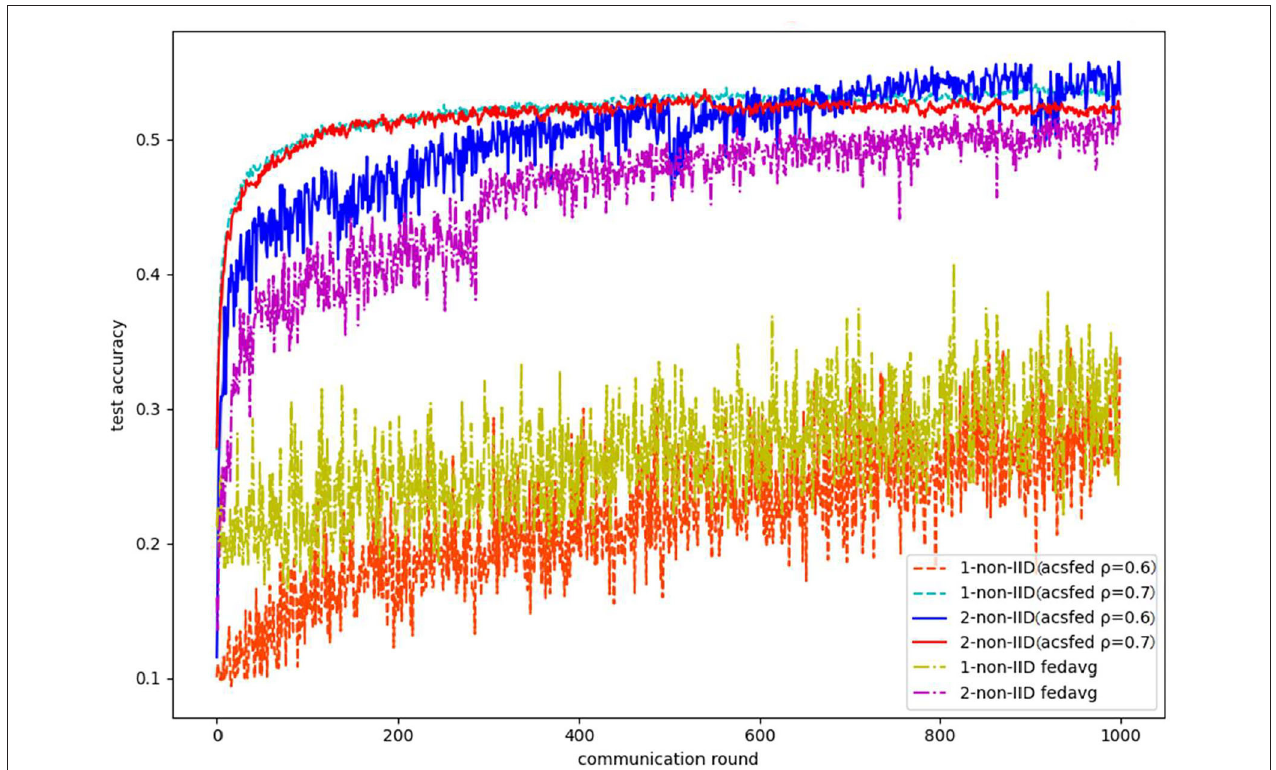
FIGURE 9 | Test accuracy on CIFAR 10 in the 1-class non-IID